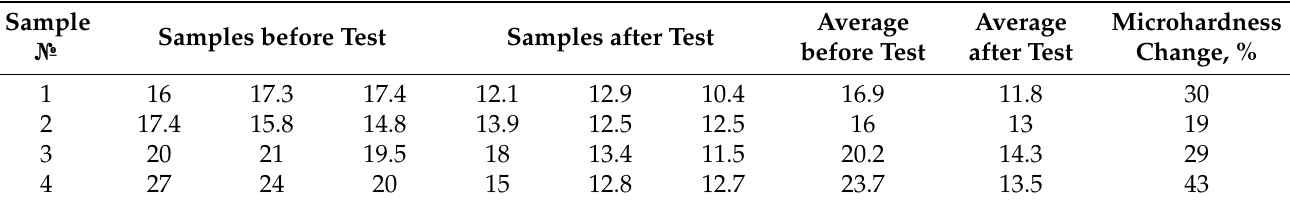
Table 4. Microhardness of testing